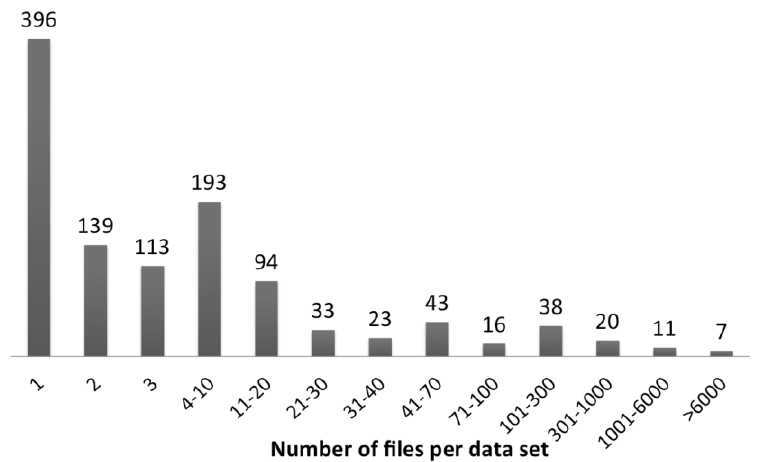
Figure 1. Distribution of number of files per data set in the Oak Ridge National Laboratory Distributed Active Archive Center (ORNL DAAC ) data holdings (n = 1126).